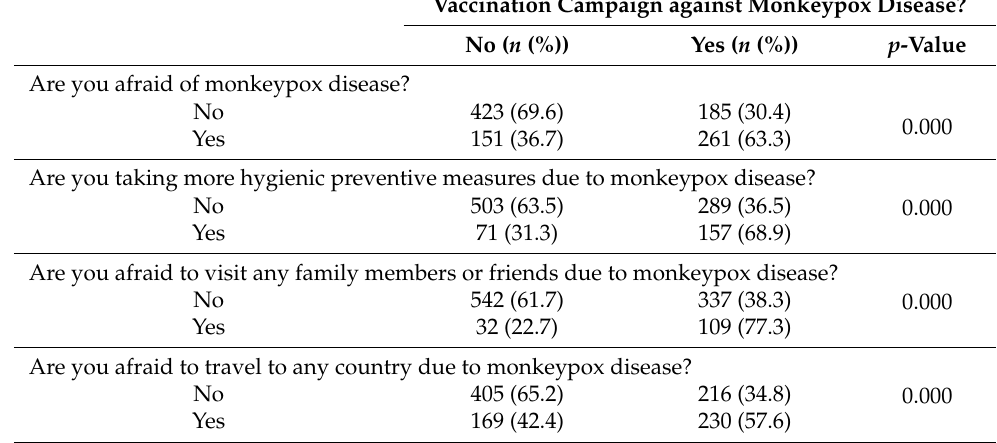
Table 6. Public perceptions about the preventive measures and recommendations for monkeypox vaccination.